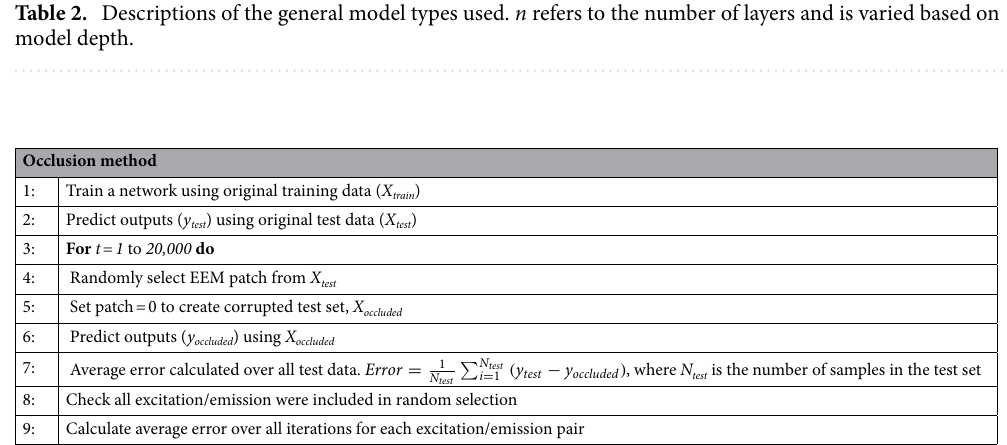
Table 3. Description of the occlusion method used to identify spectral heat maps or areas of